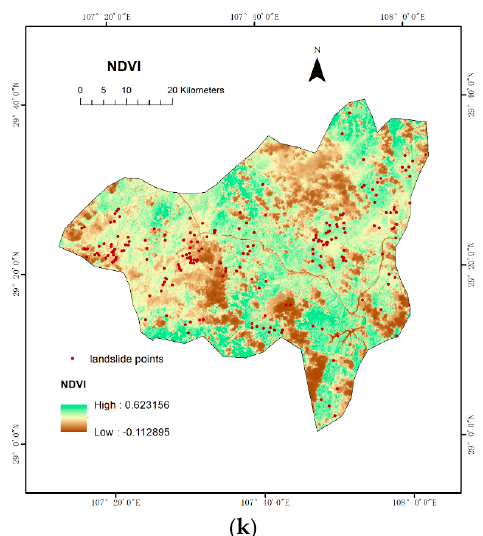
Figure 2. Maps of landslide predisposing factors: ( a ) elevation; ( b ) slope; ( c ) aspect; ( d ) curvature; ( e ) distance to road; ( f ) distance to railway; ( g ) distance to river; ( h ) distance to fault; ( i ) precipitation; ( j ) lithology; ( k ) normalized difference vegetation index (NDVI).